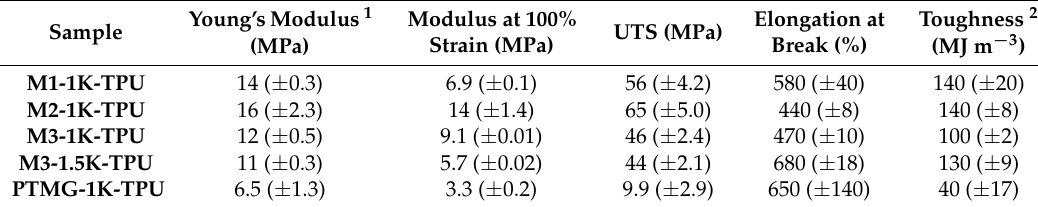
Figure 7. ( a ) TGA and ( b ) DTG curves of TPUs. Table 3. Mechanical characterizations of TPU. UTS, ultimate tensile strength.